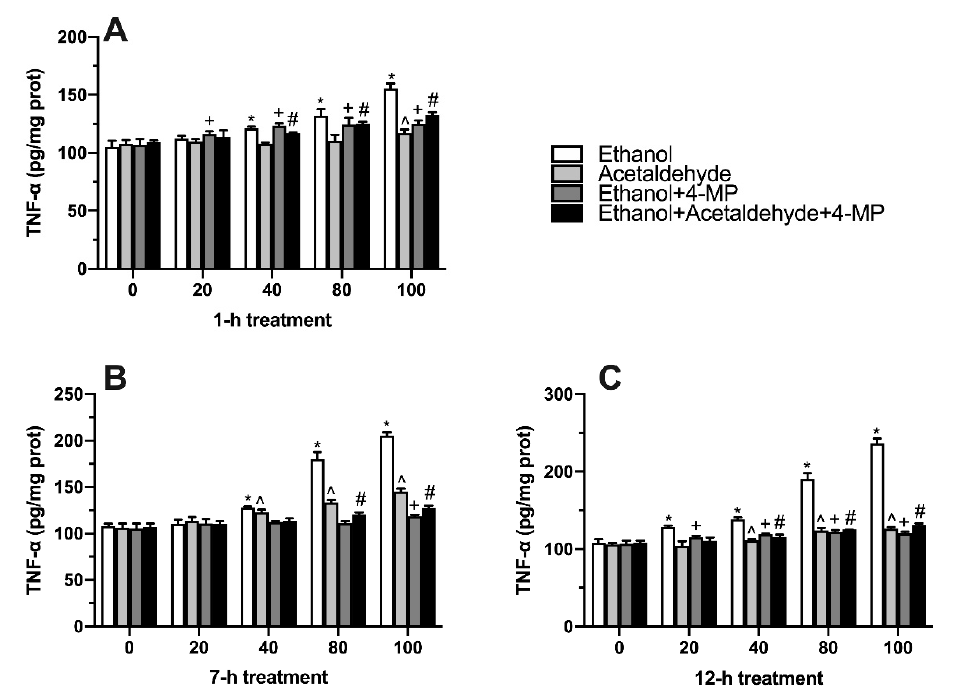
Figure 5. Effect of four different treatments on TNF- α content in L02 cell lines treated for 1 h ( A ), 7 h ( B ), and 12 h ( C ). Values represent means ± SD (n ≥ 6). * p < 0.05 compared with 0 mM ethanol, ^ p < 0.05 compared with 0 µM acetaldehyde, + p < 0.05 compared with 0 mM ethanol + 500 µM 4-MP, # p < 0.05 compared with 0 mM ethanol + 0 µM acetaldehyde + 500 µM 4-MP.